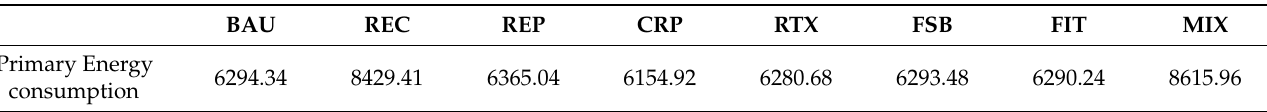
Table 2. Primary energy consumption in 2060 (million